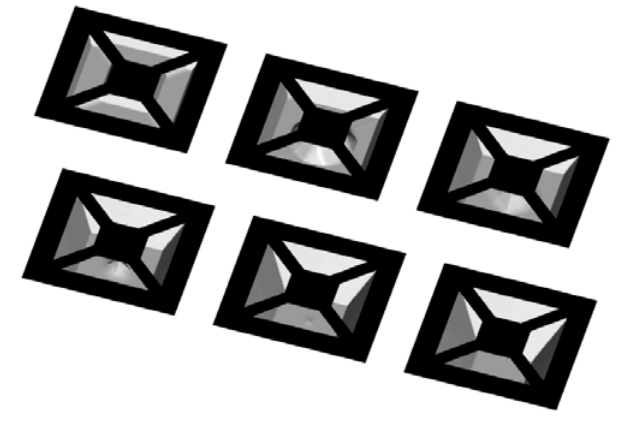
Figure 12. Formation of a released suspended plate. Initial aperture is aligned to <110>